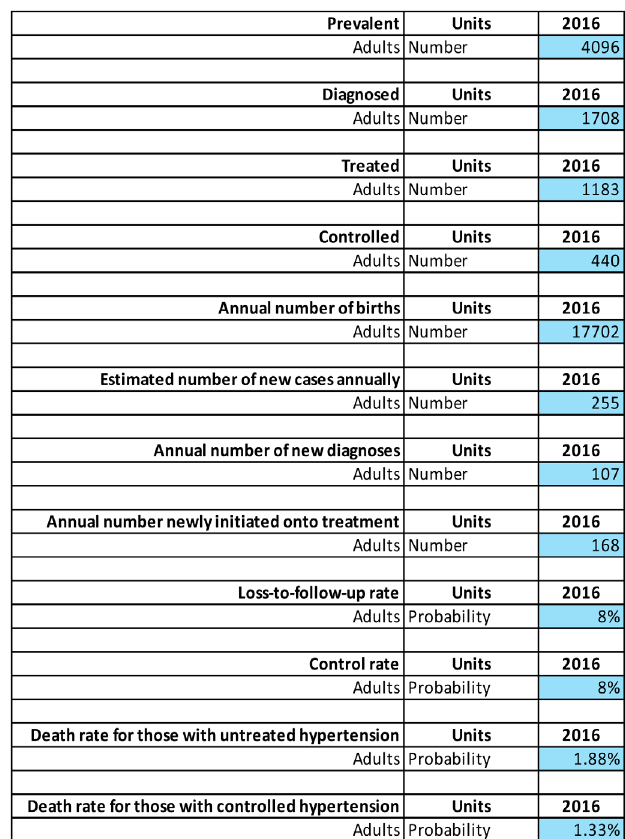
Figure 6. Illustration of the data entry book for the hypertension example depicted in Figure 5.